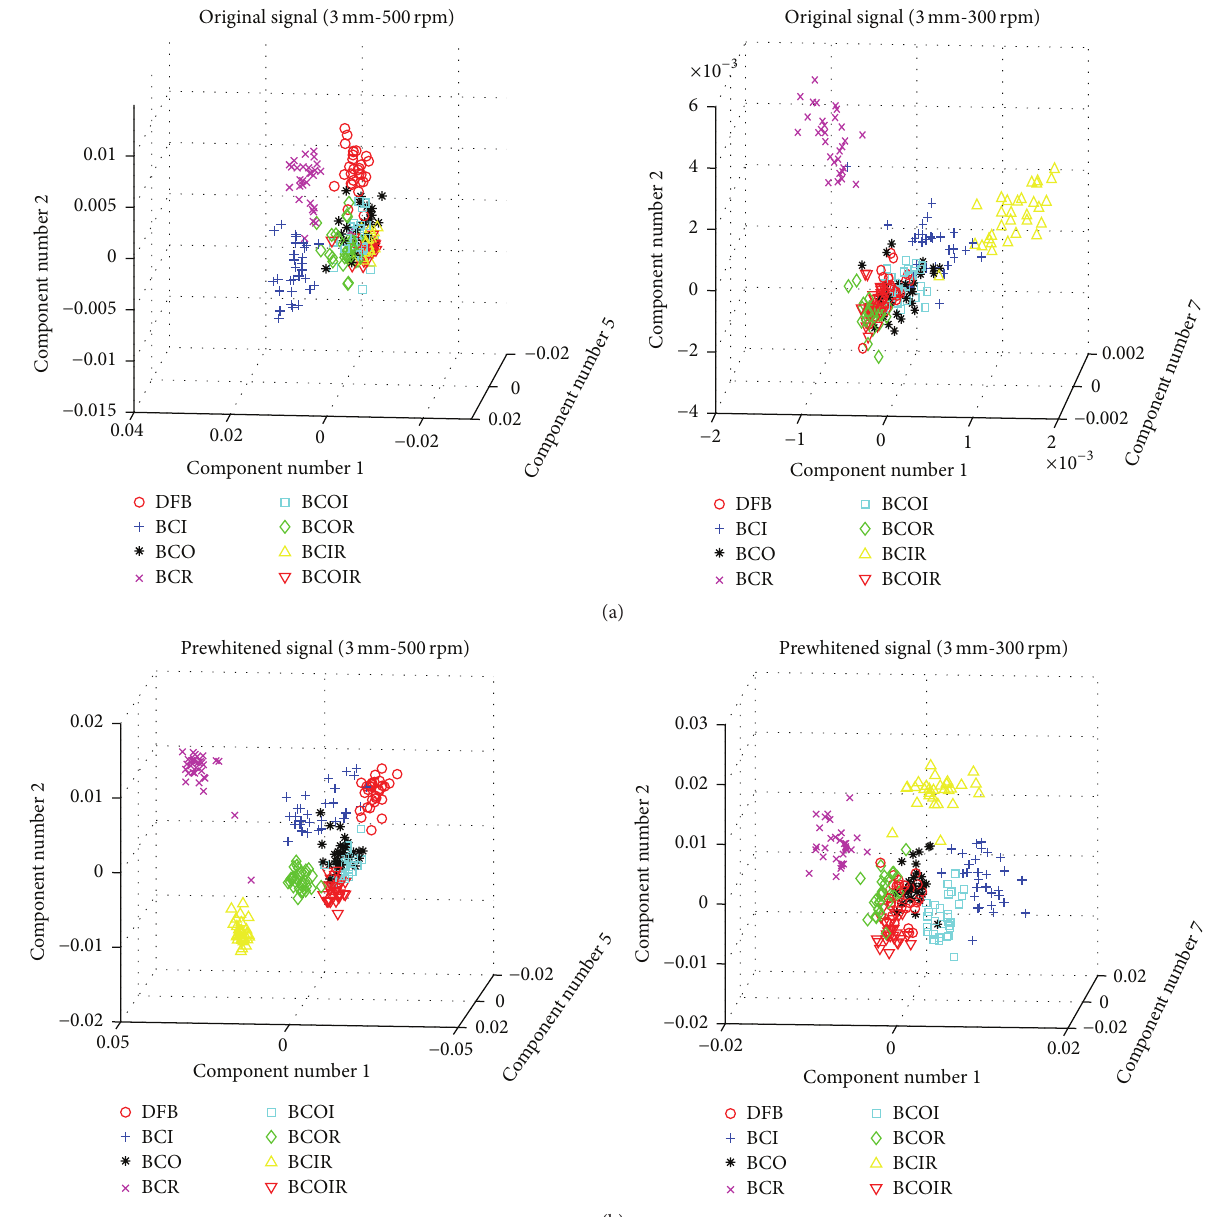
Figure 6: Feature distribution spaces with a bearing crack size of 3 mm. (a) Before prewhitening and (b) after prewhitening.